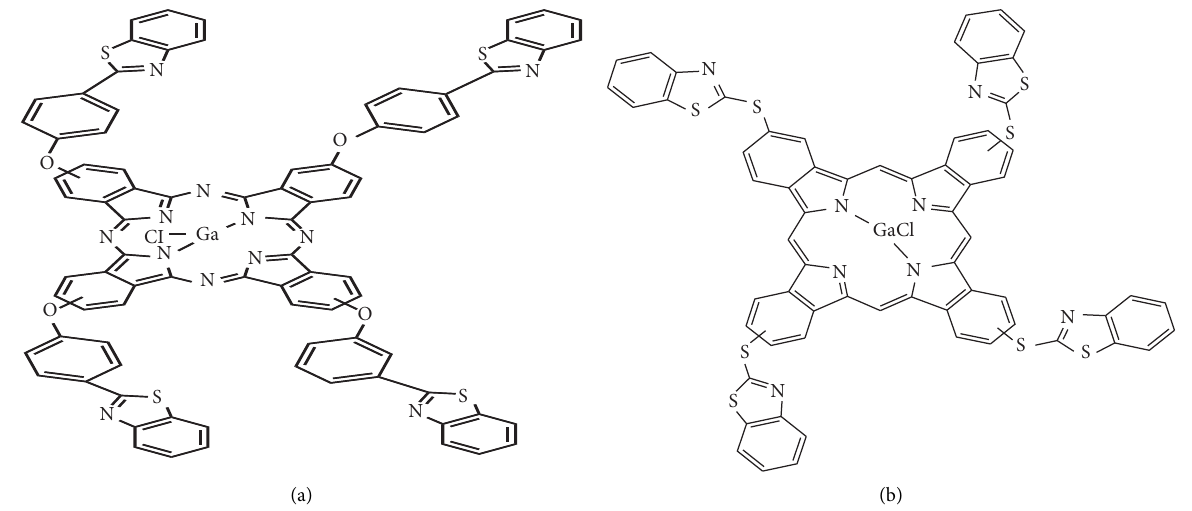
Figure 1: Structures of tetrakis[(4-benzo[d]thiazol-2ylphenoxy) phthalocyaninato] gallium (III) chloride ( 1 ) (a) and tetrakis[(benzo[d]